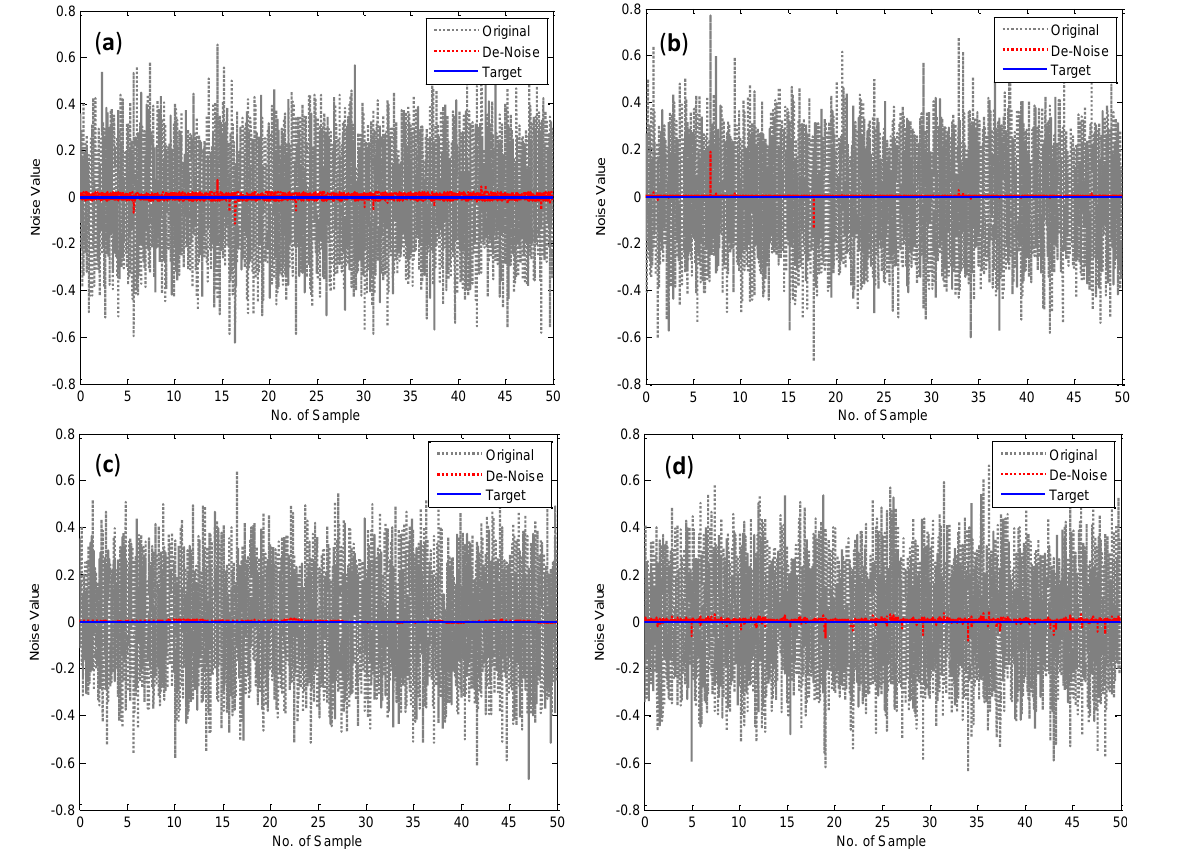
Figure 5. Comparison of the simulation results ( a ) Back-Propagation Neural Network (BPN); ( b ) Cascade- Forward Back-Propagation Neural Network (CFN); ( c ) Adaptive Filter Neural Network (ADFN); (d) Extended Kalman Filter Neural Network